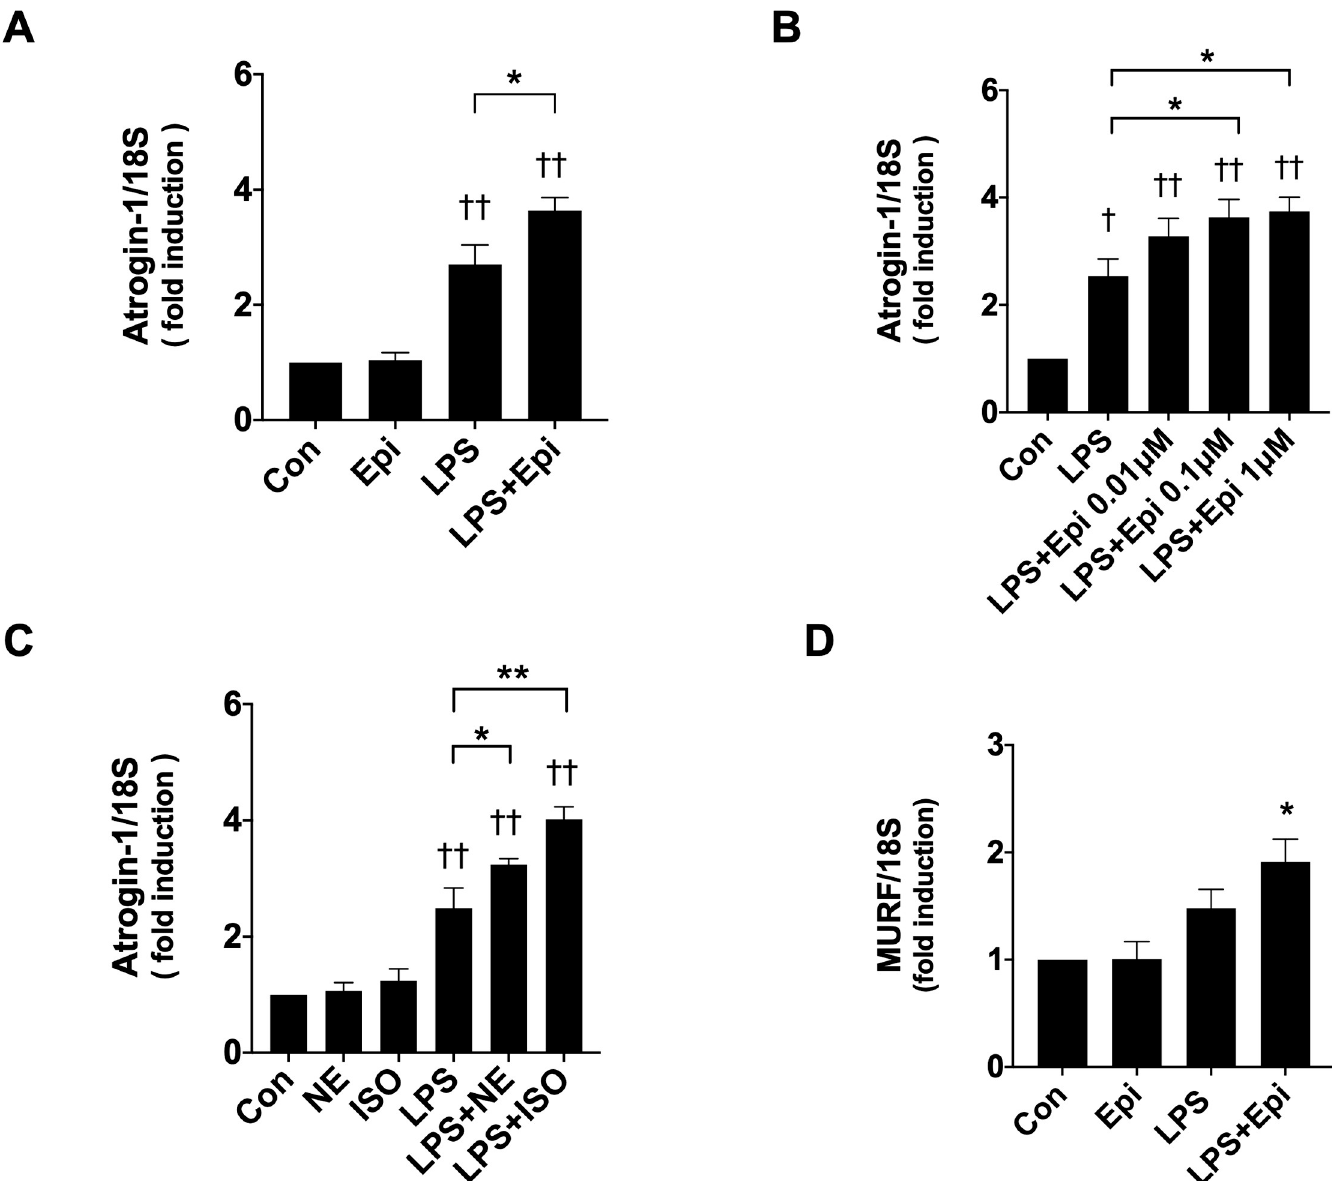
Fig 2. Catecholamines increased LPS-induced Atrogin-1 messenger ribonucleic acid (mRNA) levels. C2C12 myotubes were exposed for 3 h to LPS (50 ng/ml) and/ or Epi (1 μ M) (A and D), Epi of the indicated concentration (B) and NE (1 μ M) or ISO (1 μ M) (D). Atrogin-1 (A, B and C) and MuRF1 (D) mRNA expression levels were analyzed by quantitative reverse transcription polymerase chain reaction (qRT-PCR) (n = 4). Data are normalized to the 18S rRNA expression level, and fold induction relative to the value of the control condition is presented as mean ± SEM (n = 4). (†P < 0.05 and ††P < 0.005 compared with control, � P < 0.05 and �� P < 0.005 for comparisons between the indicated